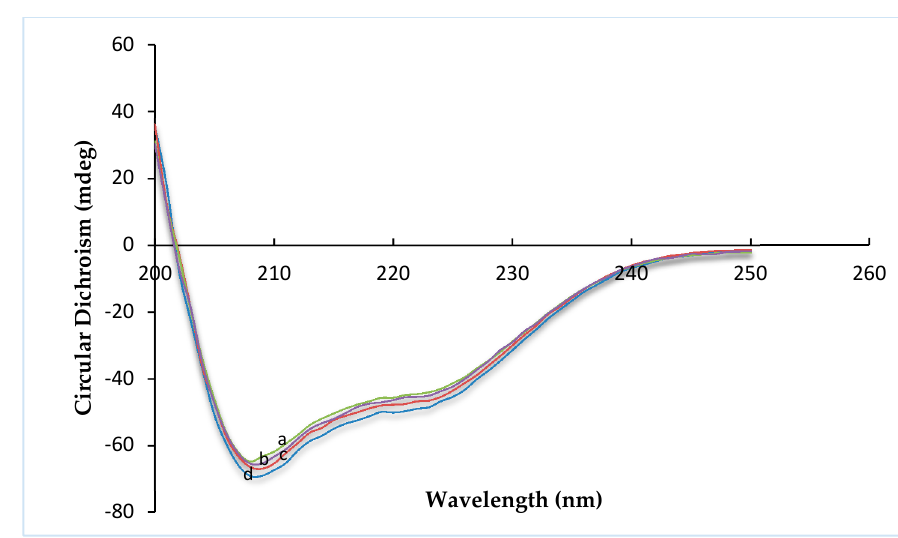
Figure 2. Far-UV CD spectra. a, insulin; b, R6EW-insulin; c, R8-insulin; d, SAR6EW-insulin.